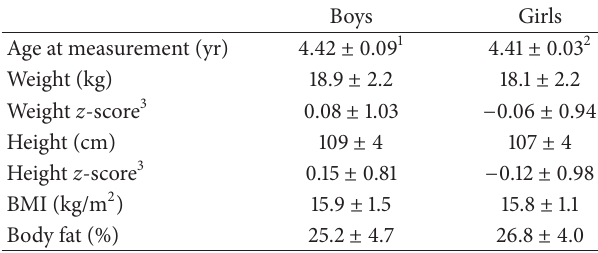
Table 1: Characteristics of boys and girls studied for body compo- sition by means of air displacement plethysmography (boys = 43, girls =